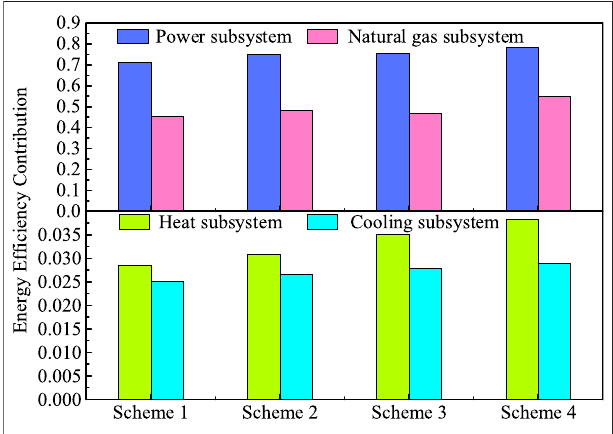
FIGURE 10 | The comparison of energy ef fi ciency contribution under four con fi guration schemes.